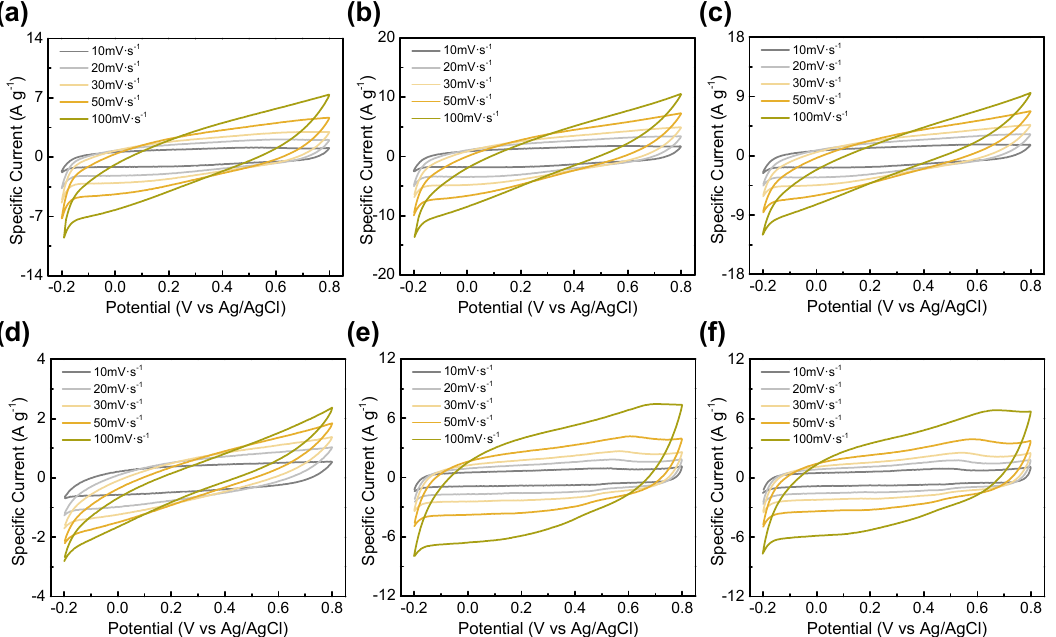
Figure 7. Cyclic voltammograms of ( a ) BTC-612, ( b ) BTC-613, ( c ) BTC-614, ( d ) BTC-712, ( e ) BTC-713, and ( f ) BTC-714 at scan rate from 10 to 100 mV∙s −1 .